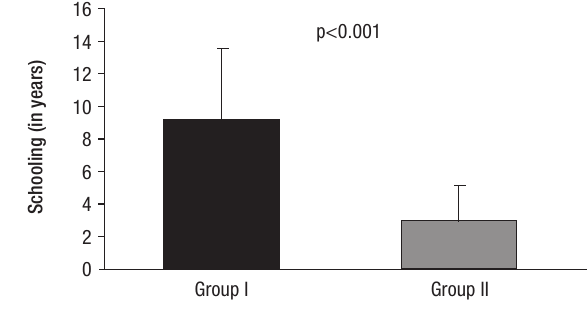
Figure 1. Educational